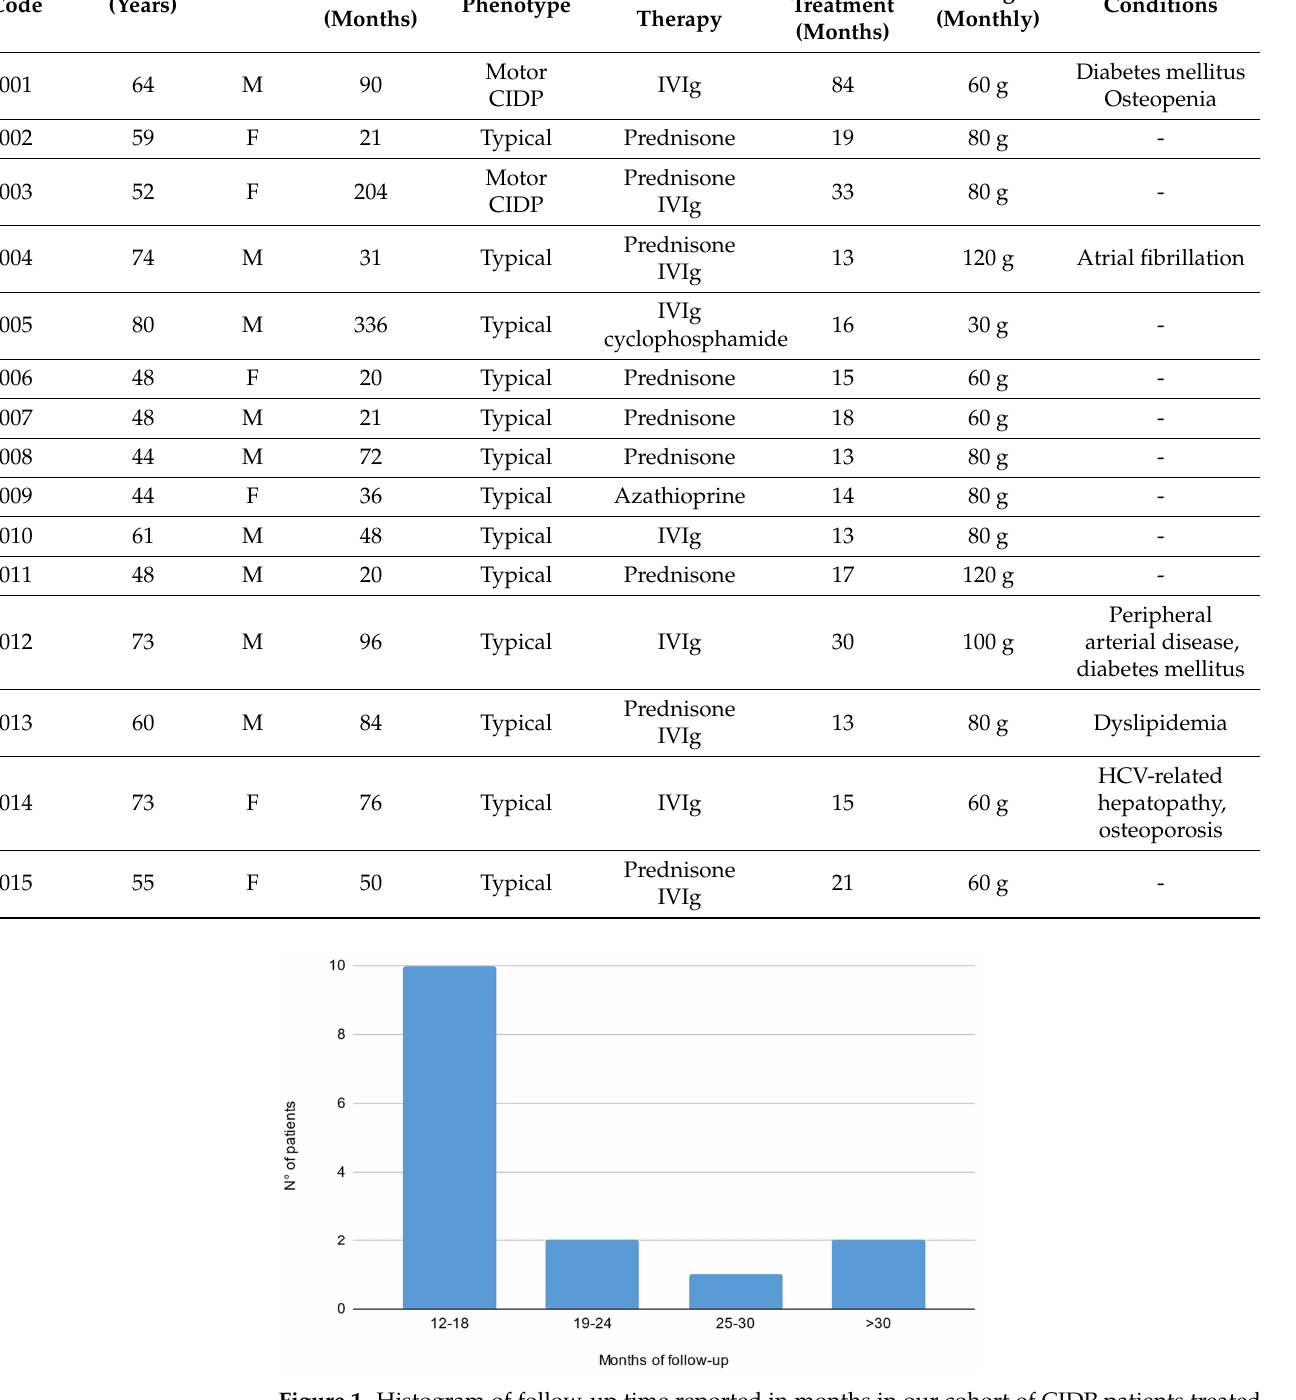
Figure 1. Histogram of follow-up time reported in months in our cohort of CIDP patients treated with